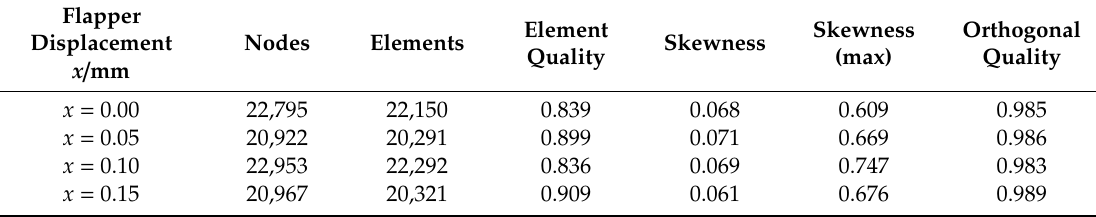
Table 4. Grid model parameters of different spacing between nozzle and flapper.